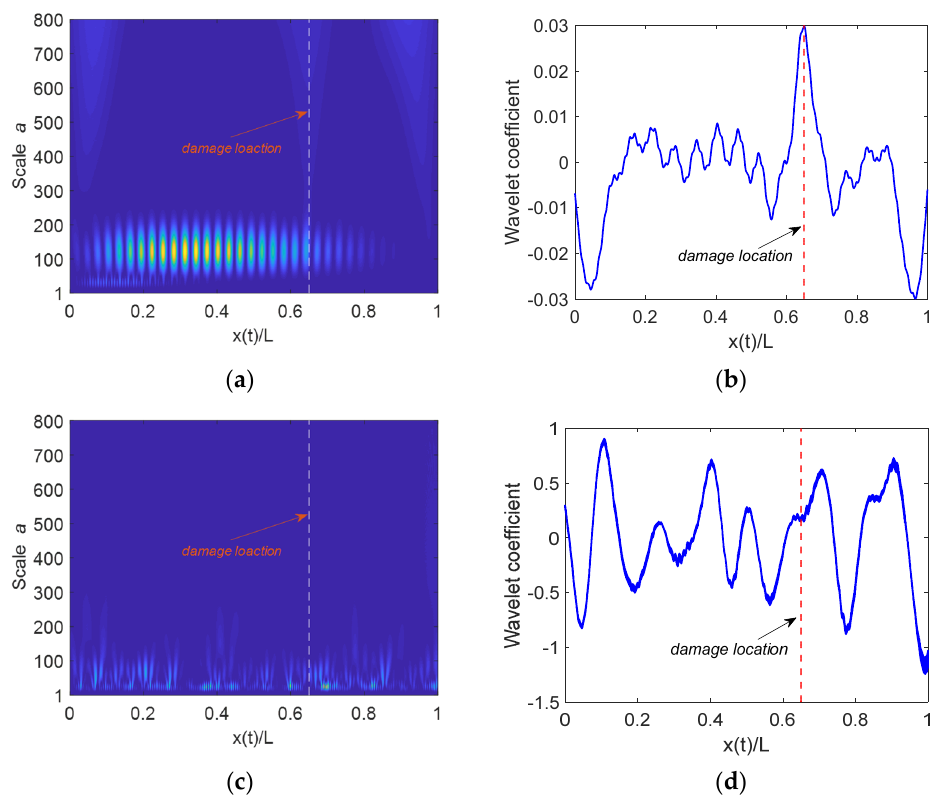
Figure 7. Identifying the bridge damage. ( a ) scalogram without road roughness; ( b ) particular wavelet coefficient without road roughness; ( c ) scalogram with road roughness; ( d ) particular wavelet coefficient with road roughness.